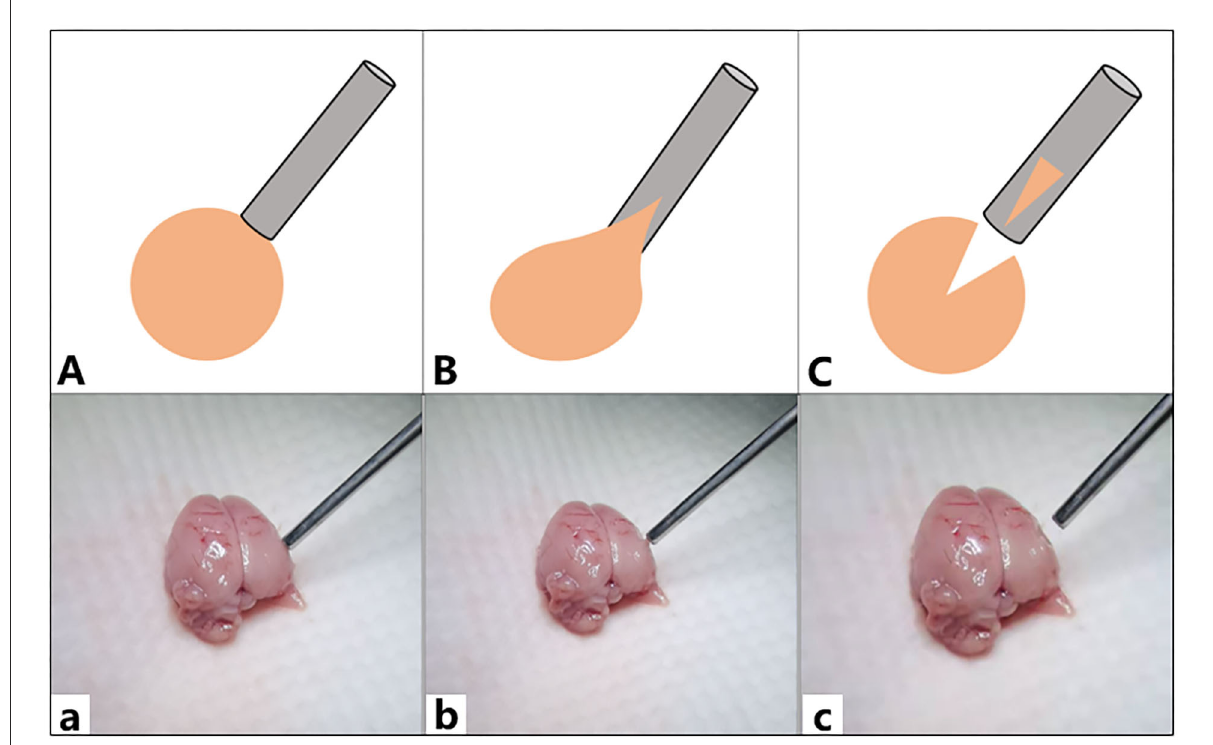
FIGURE5 Graph showing the damage of rat brain tissue. (A,a) The tip negative pressure was < 5.2 ± 0.7 kPa, and there was no significant damage to the brain tissue. (B,b) The tip negative pressure was 5.2–29.2 kPa, and a mild destruction on the brain tissues was observed. (C,c) The tip negative pressure was > 29.2 ± 2.0 kPa, and the suction tube could directly suction away the brain tissue causing a severe